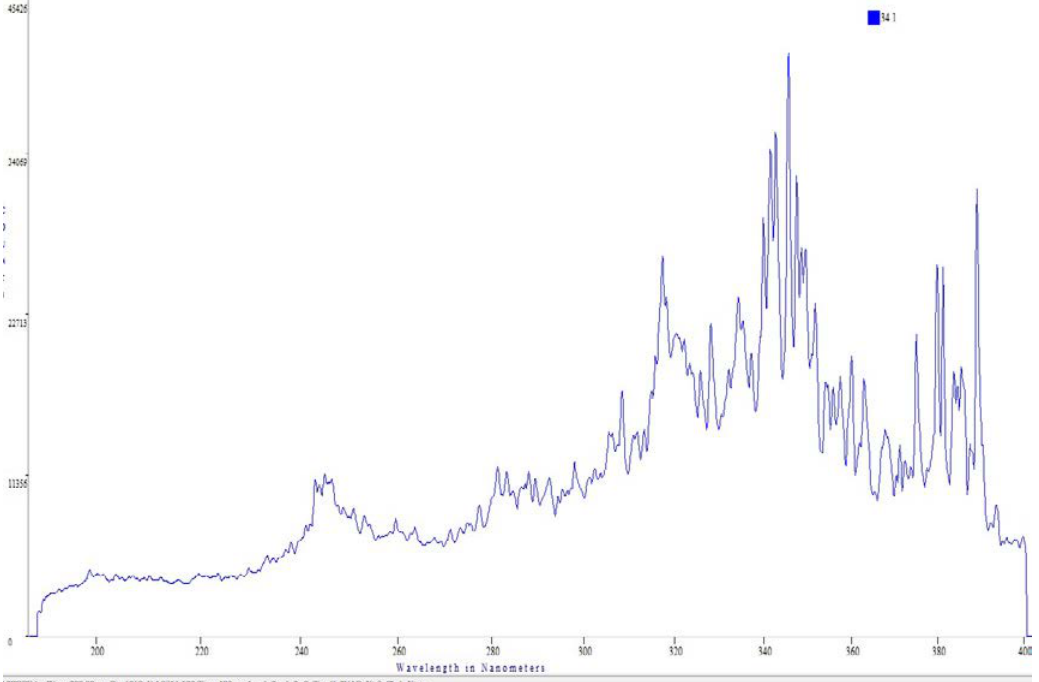
Fig. 2: Emission spectra of laser energy 600 mJ with 1Hz repetition